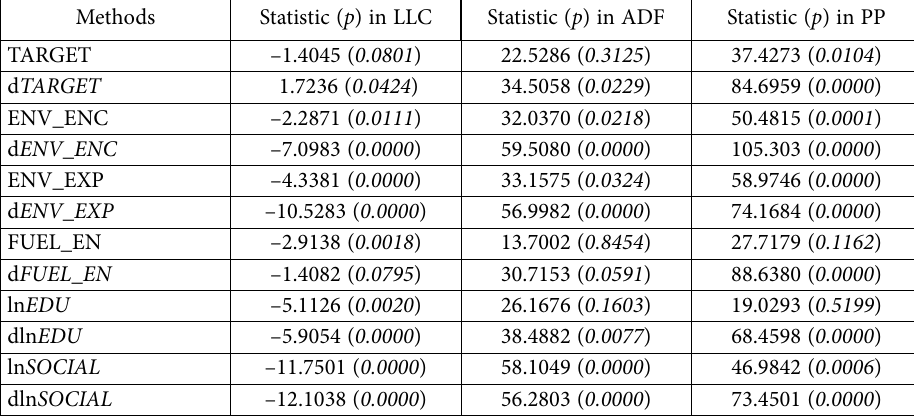
Table 5. LLC unit root test, ADF – Fisher Chi-square and PP – Fisher Chi-square (source: author’s own